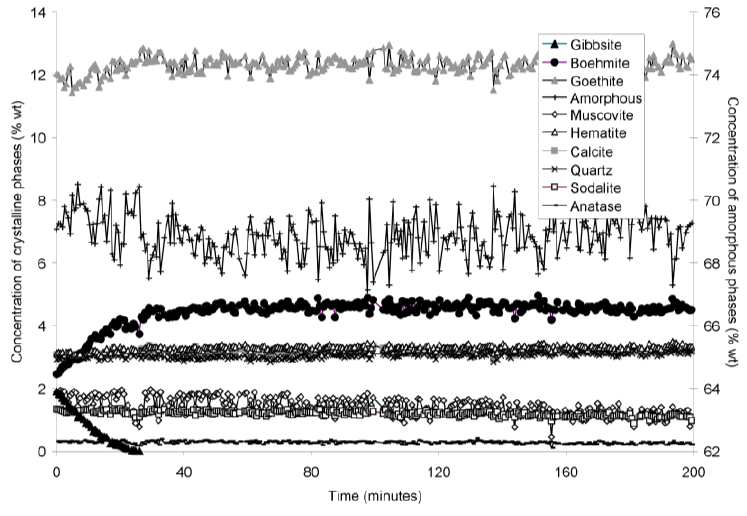
Figure 6. Concentration of crystalline and amorphous phases in bauxite residue slurry in capillary reaction vessels as a function of treatment time at 170 °C, as determined by Rietveld-based quantitative mineral analysis of X-ray diffractograms. Note that amorphous content is plotted on the secondary Y axis and represents contributions from X-ray amorphous minerals in bauxite residue, water in the slurry, and the fused silica